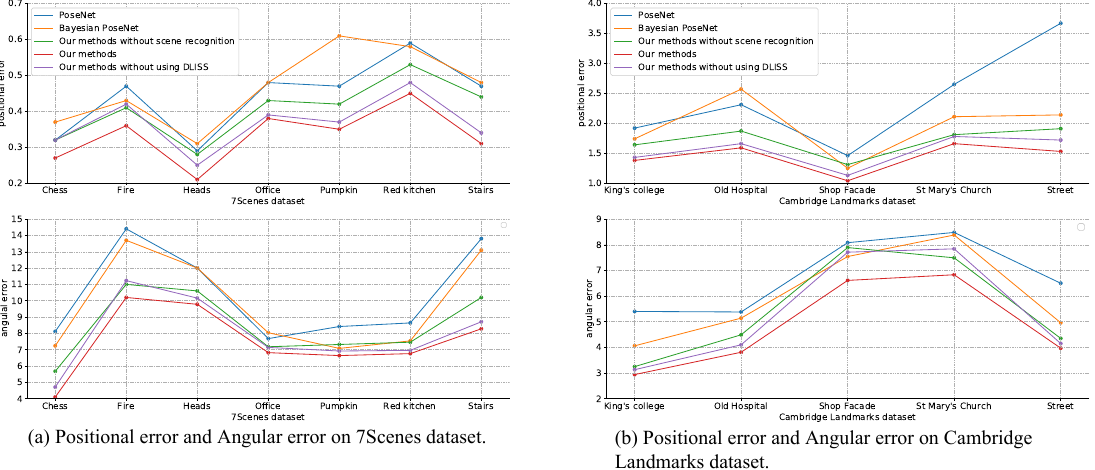
Figure 11. Comparison of the 7Scenes dataset and the Cambridge Landmarks dataset. This shows that our network performs better than PoseNet and Bayesian